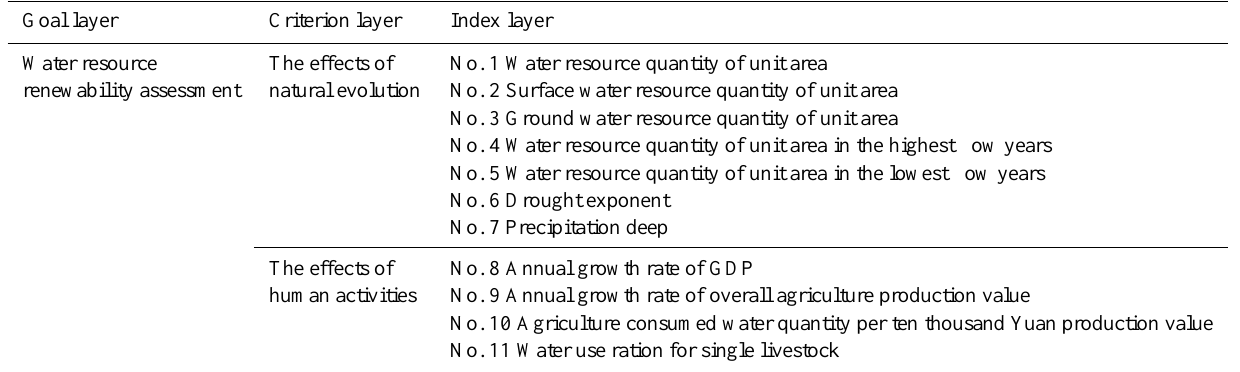
Table 3. The index meaning of each layer.